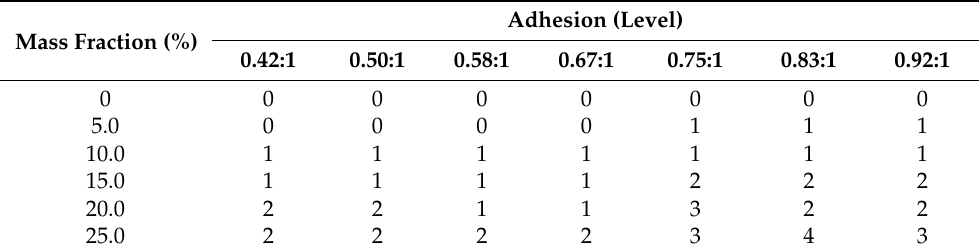
Table 5. Effect of microcapsule concentration and core-shell ratio on the adhesion of the paint film onto the substrate.